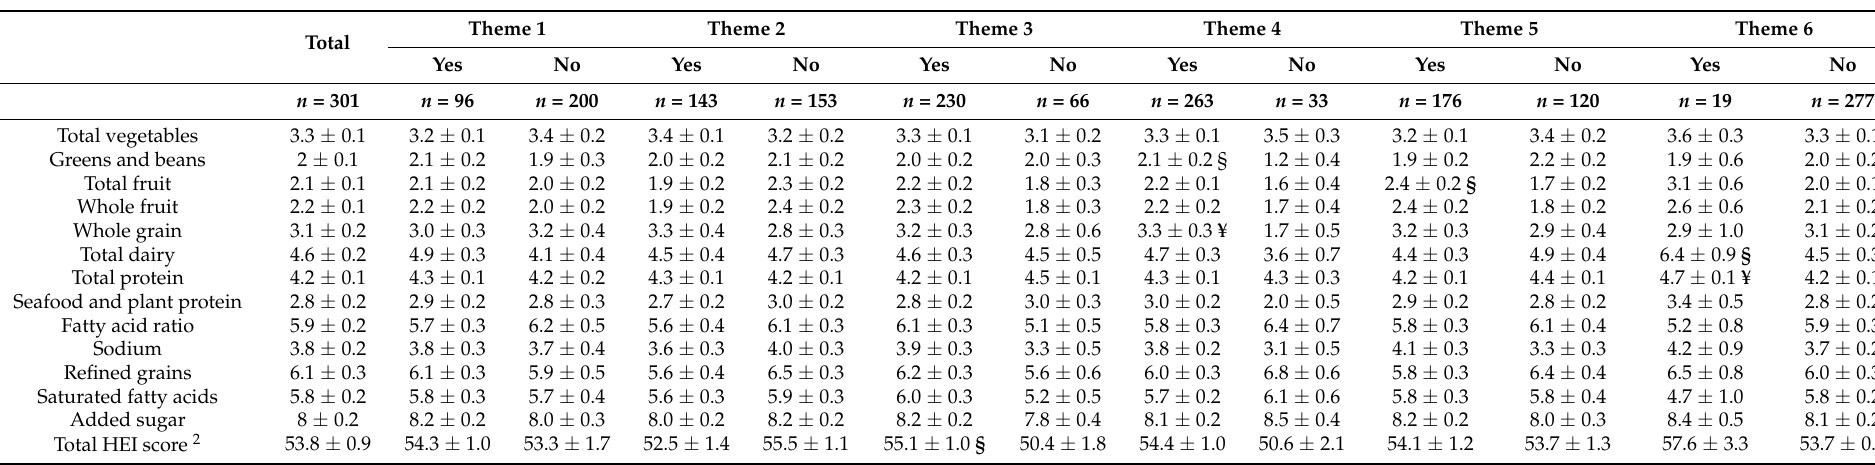
Table 4. Healthy Eating Index 2015 Component and Total Scores Across Themes 1 in College Students during the Early COVID-19 Pandemic ( n =